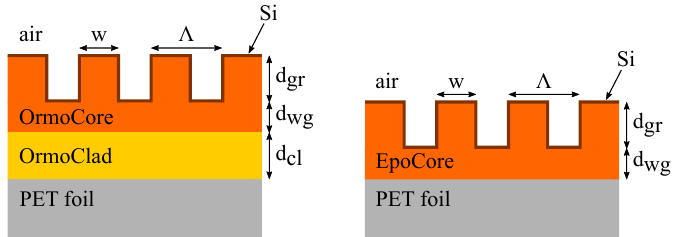
Figure 2. Schematic representations of the GMR gratings in the optical polymer OrmoCore and